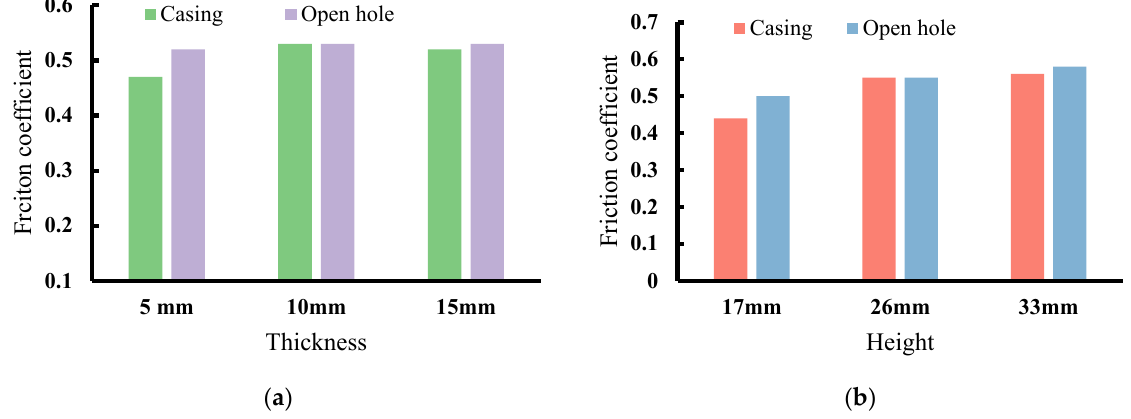
Figure 2. Determination of friction coefficient of drill pipe under different cuttings thickness and cuttings coating height conditions. ( a ) at different thicknesses. ( b ) at different heights.